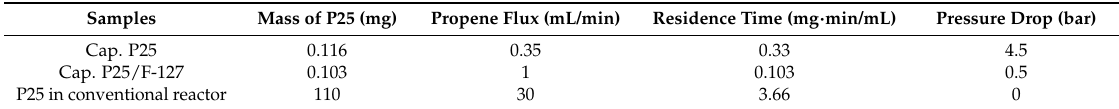
Table 1. Mass of P25 inside the microreactors and the conventional reactor, flow rate of propene and the residence time used in the photooxidation experiments and registered pressure drop.